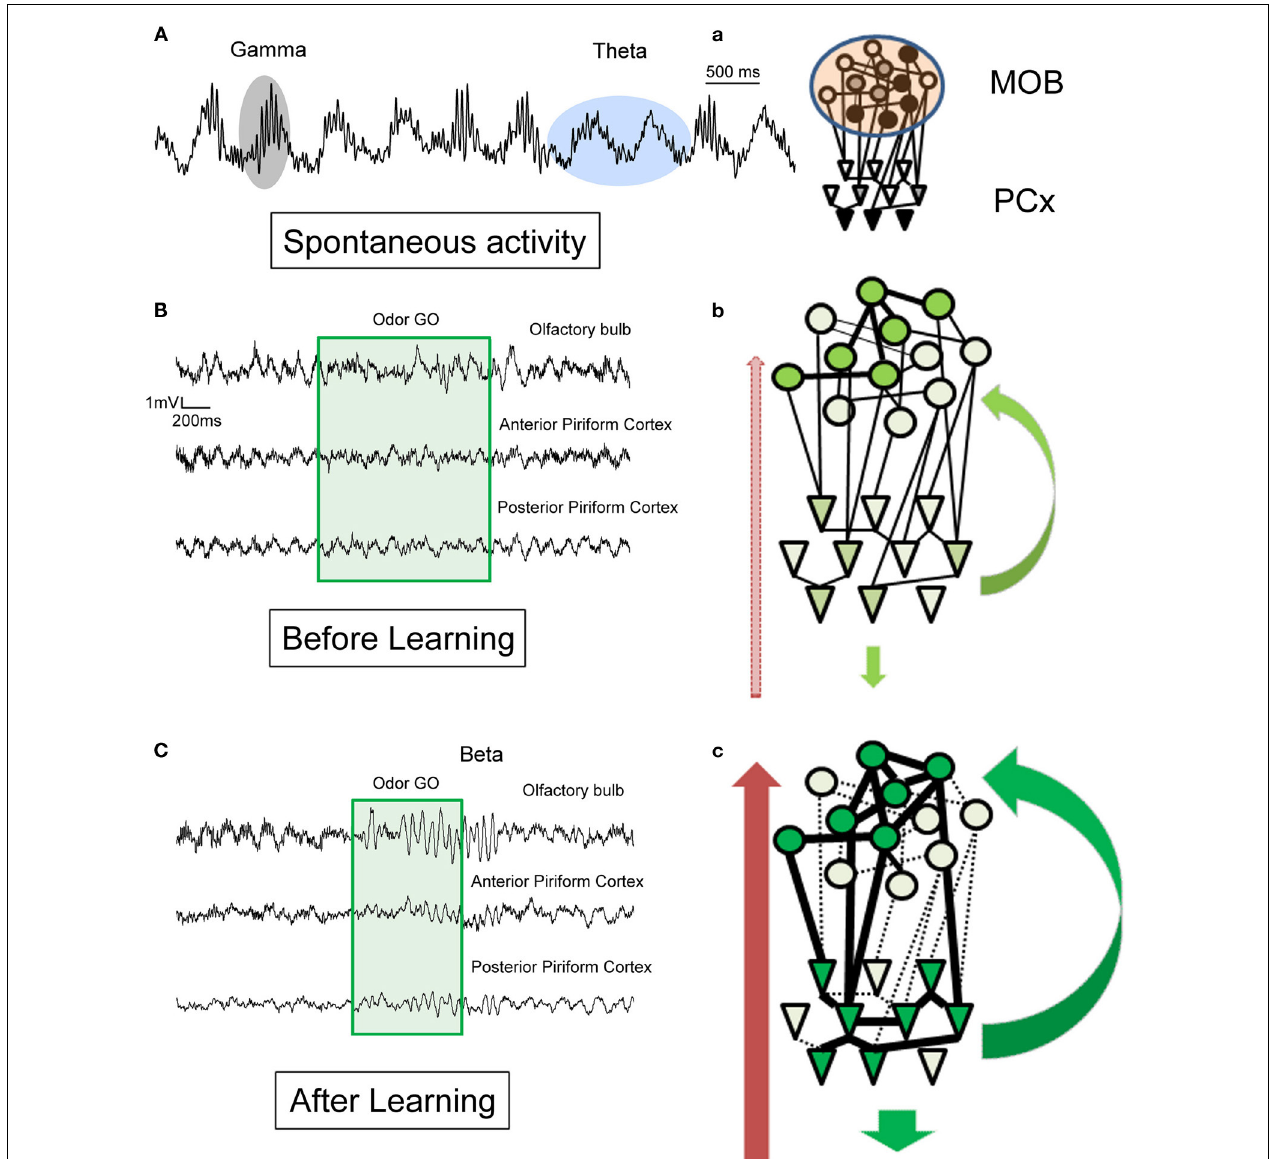
FIGURE 3 | Schematic illustration of hypotheses for the generation of beta (15–35Hz) and gamma (60–90Hz) rhythms in the olfactory bulb and the piriform cortex in awake behaving animals. Example of raw LFP traces recorded (A) in the MOB in the absence of olfactory stimulation and (B) in MOB and two different regions of the PCx before learning and (C) after learning during a conditioned discrimination paradigm (Go/No-Go). a–c : Corresponding schematic representation of MOB and PCx interconnected networks and centrifugal modulation. The level of neuromodulation is represented by the red arrow on the left, the level of cortical feedback by green arrow on the right. (A) Spontaneous activity: in the absence of olfactory stimulation. Observe the regular theta respiratory modulation (around 2Hz) and the associated bursts of gamma activity (60–90Hz). See also in (B) and (C) the portion just preceding the odorant sampling (green square area) how the gamma bursts decrease in the posterior part of the PCx compare to the MOB and anterior part of PCx. a : In the absence of olfactory stimulation, the level of activation in both networks is weak and variable and both structures are dominated by theta and gamma activity. Gamma activity is transmitted from the MOB to the PCx. (B) Before learning: during odorant